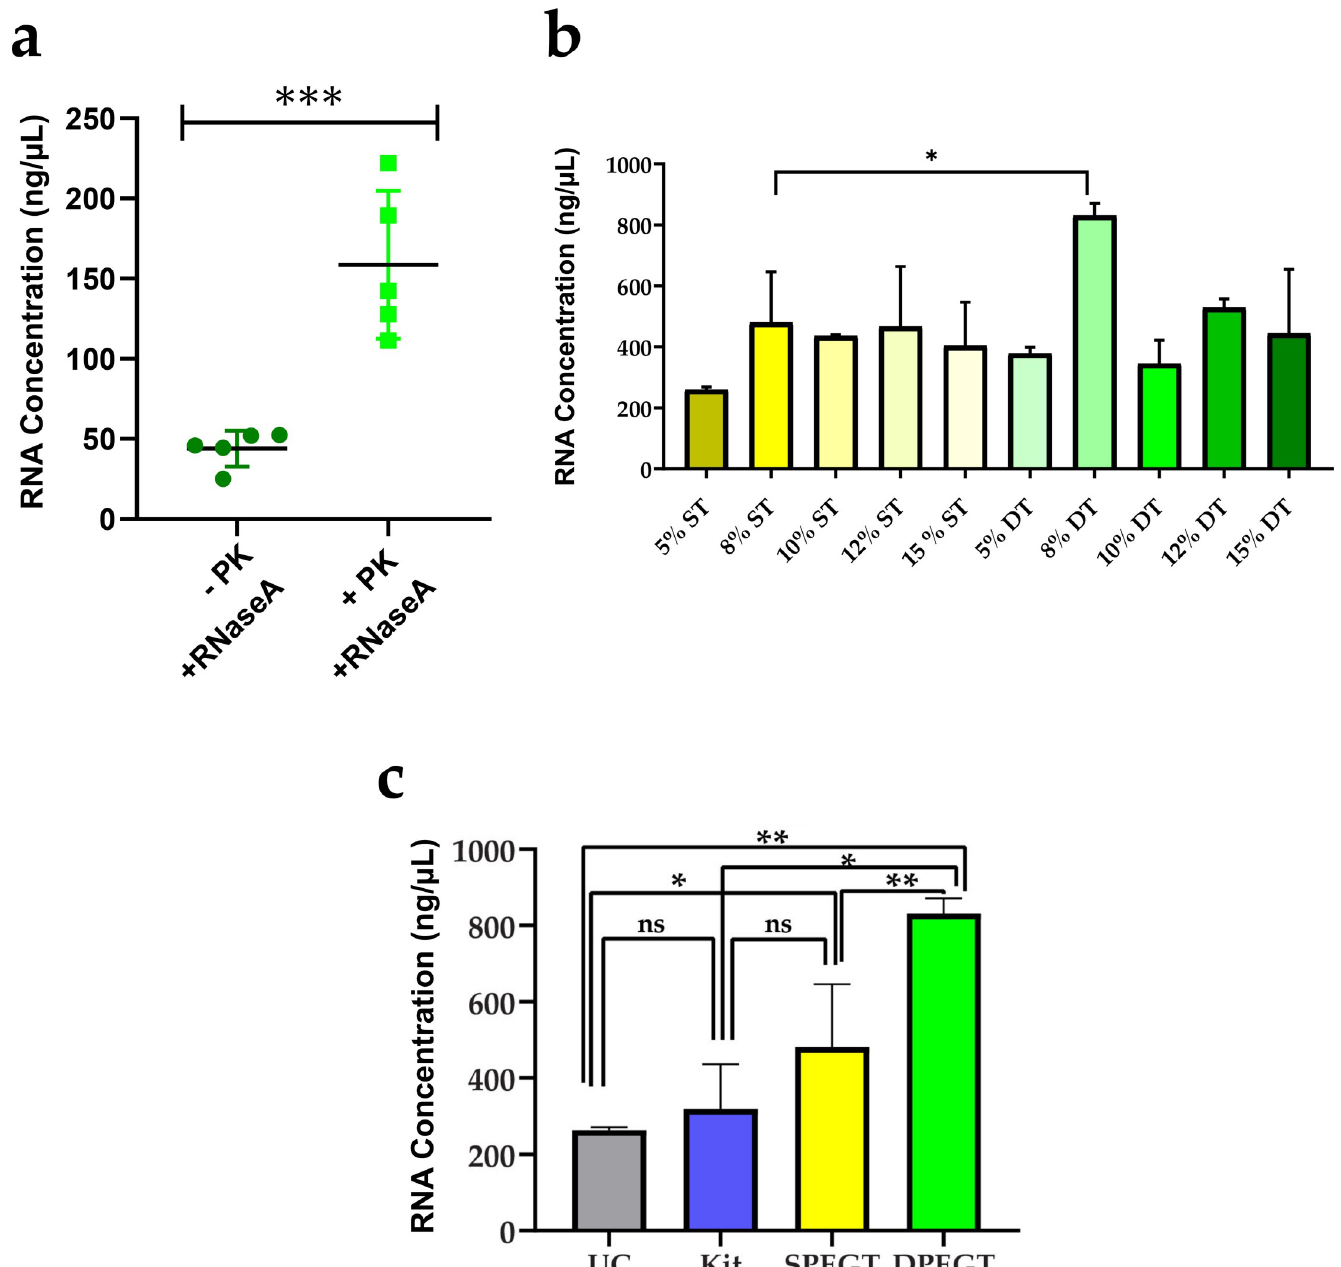
Fig 4. Total RNA concentration of enriched plasma sEVs. Isolation of sEVs was conducted by PEG-based methods SPEGT, DPEGT, and miRCURY kit and UC. (a) Effect of RNase A with or without proteinase k (PK) treatment on RNA yield. ��� p < 0.001 as determined by Student’s t-test, n = 5. (b) Effect of single treatment (ST) and double treatment (DT) of PEG with different concentrations on total RNA yield. Data represent the mean ± SEM. � p < 0.05 as determined by Student’s t-test. (c) Total RNA yield upon 8% SPEGT, 8% DPEGT, miRCURY kit and UC. Data represent the mean ± SEM. �� p < 0.01, � p < 0.05 and ns (not significant) as determined by either Student’s t-test or ANOVA